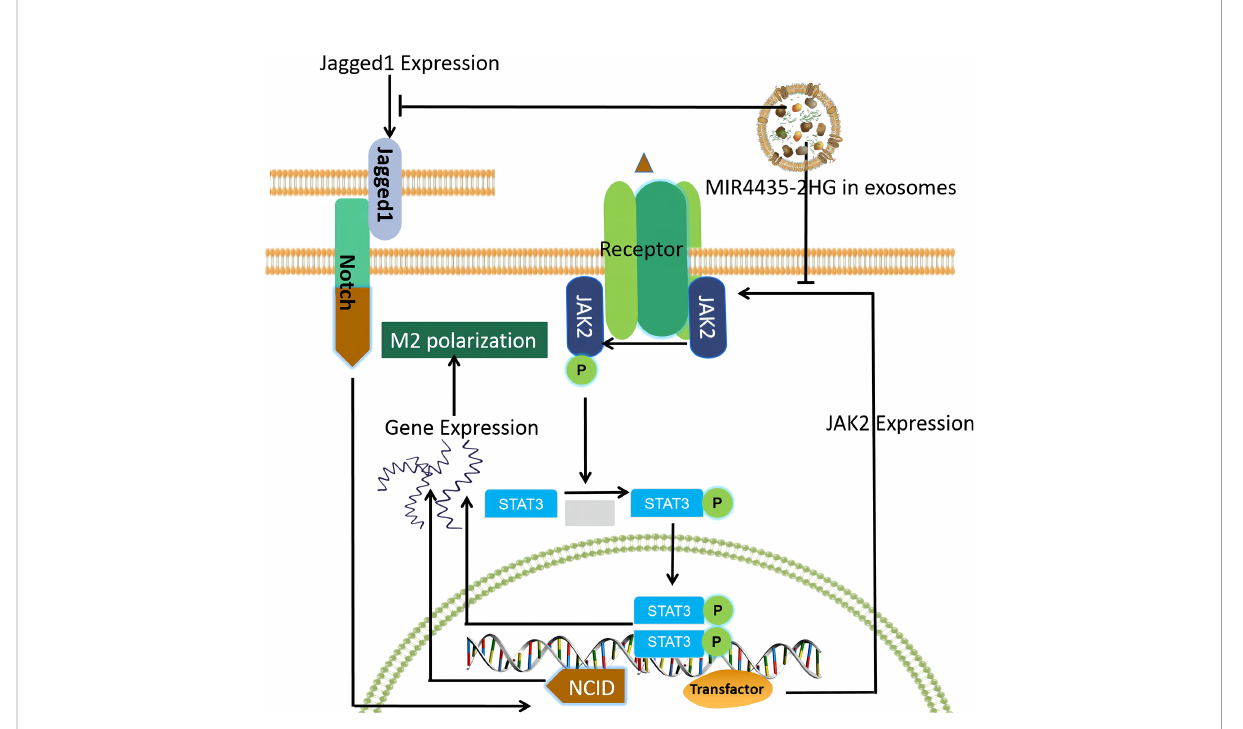
FIGURE 1 Macrophage M2 polarization pathway mapped based on our fi